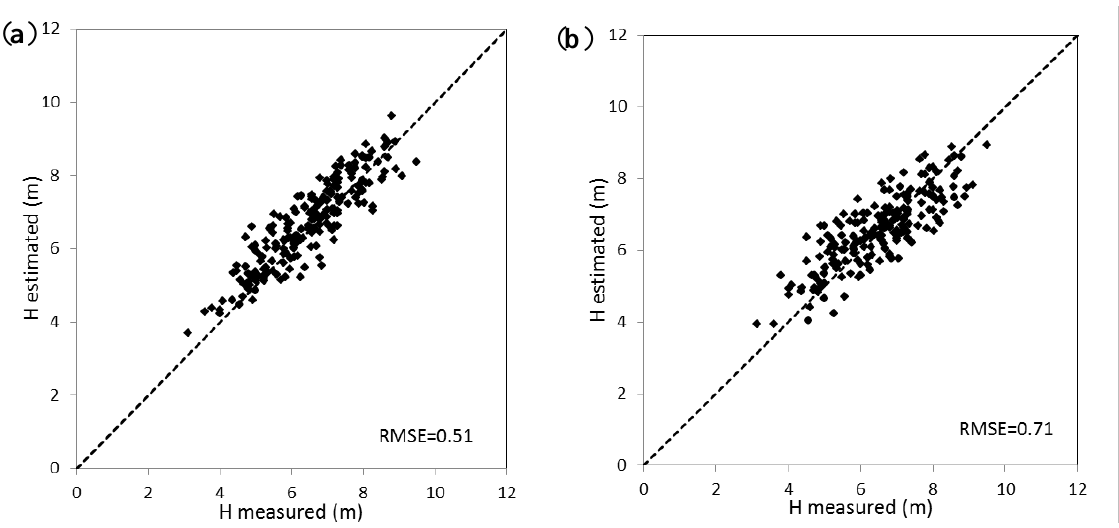
Figure 8. Field-observed versus ALS-predicted tree height. ( a ) Field-observed tree height versus ( b ) DAI-predicted tree height. The graphs show the regression function (solid lines) and 1:1 correspondence (dashed